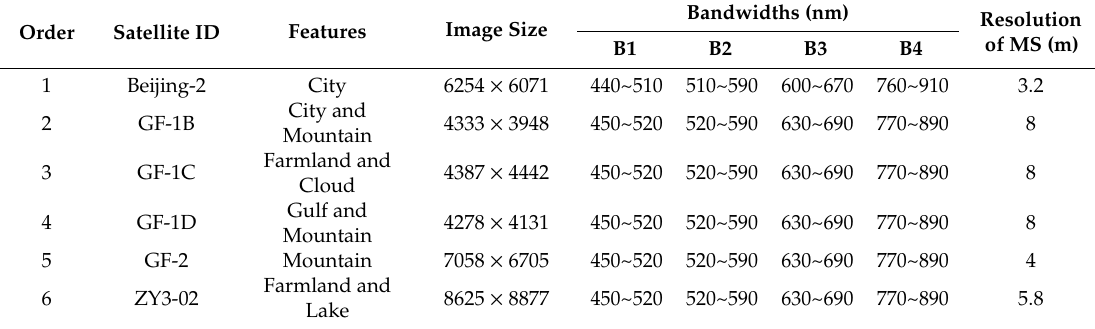
Table 1. Conditions of the experimental